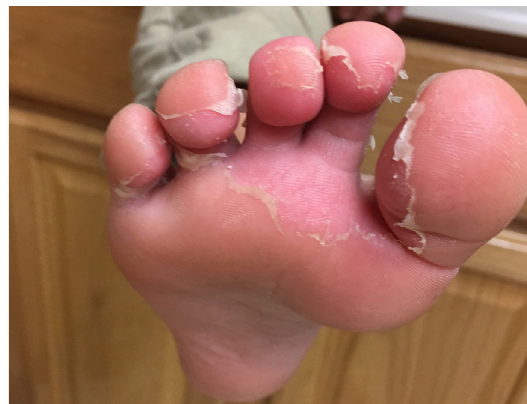
Image 3. Desquamation of feet, day 13 of